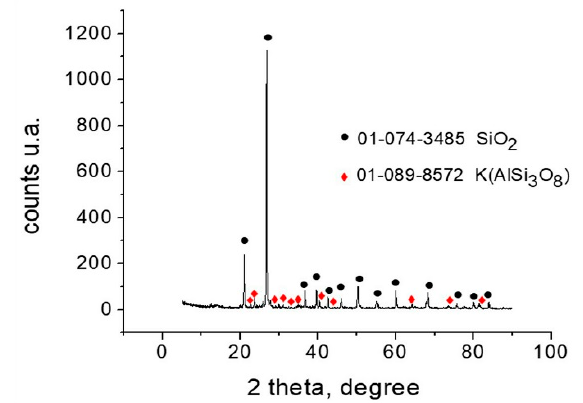
Figure 1. X-ray diffractogram showing the mineralization matrix of the Dos Carlos mine dumps of the State of Hidalgo, Mexico. State of Hidalgo,